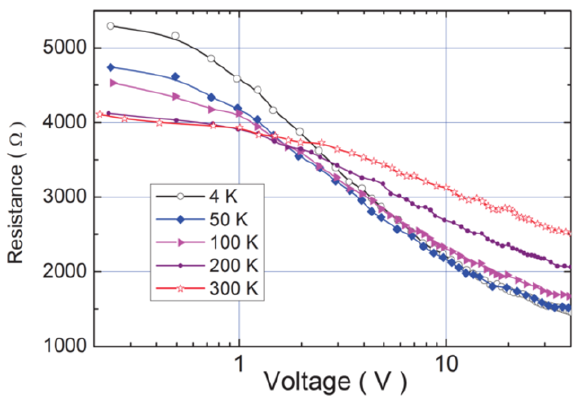
Figure 24. Dependence of SWCNT resistance versus applied voltage at different temperatures. © 2021 IEEE. Reprinted, with permission, from Ref. [70].